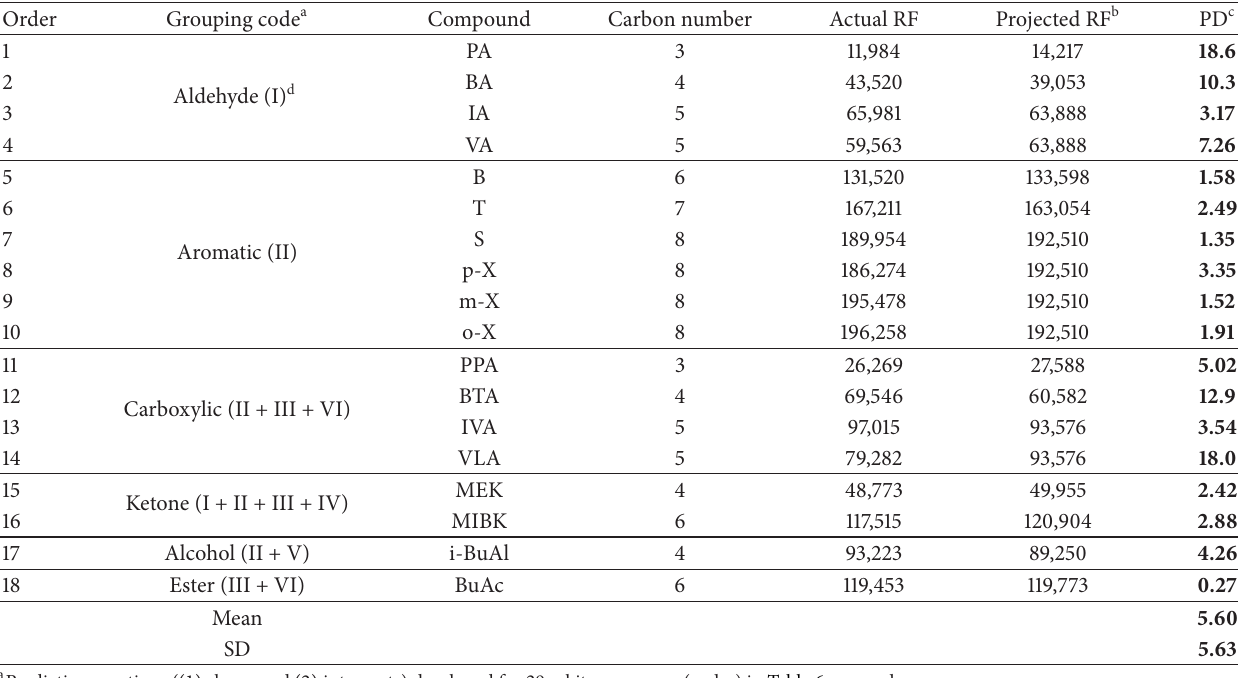
Table 7: Results of the best projected RF for individual compound when matching the best fit equation with each of the six original VOC functional groups representing all 18 reference